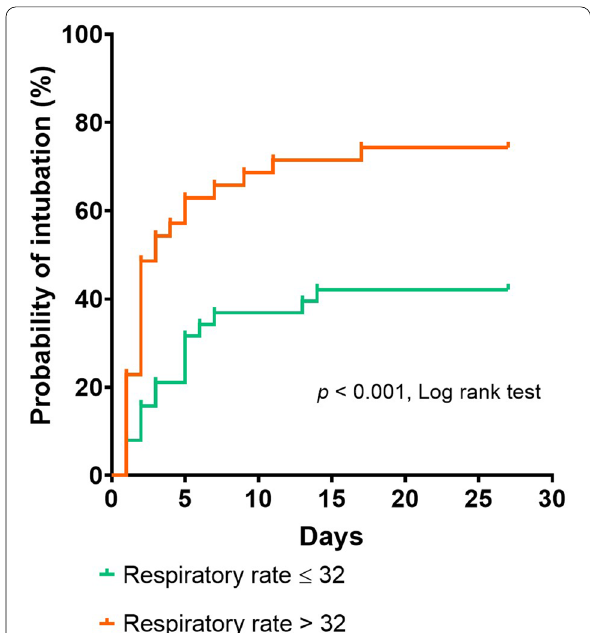
Fig. 5 Clinical study. Kaplan–Meier estimate of the cumulative probability of intubation according to the respiratory rate prior to FF‑CPAP initiation (higher or lower than 32